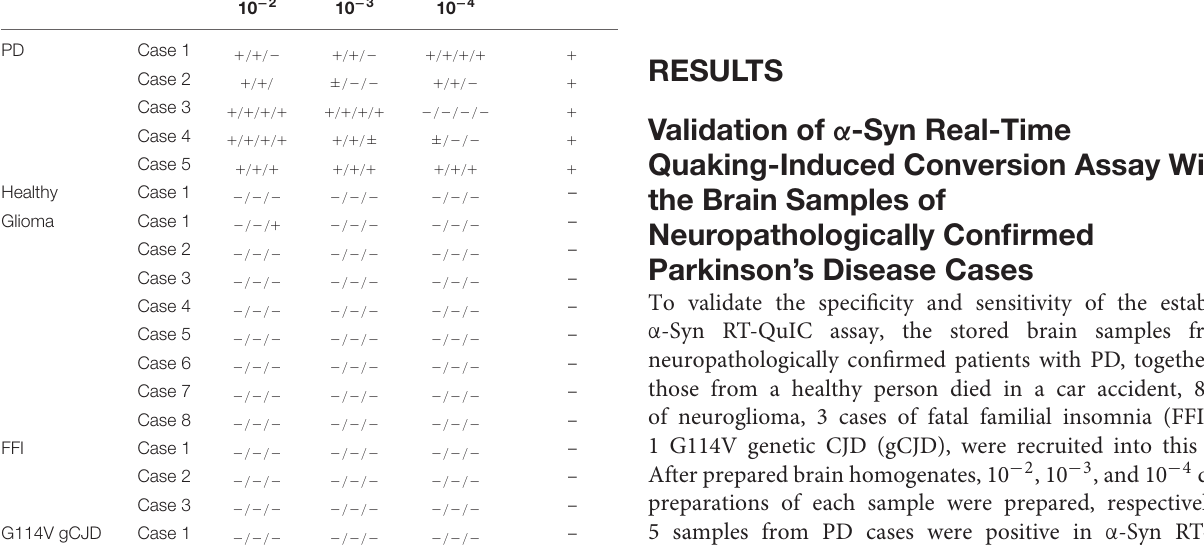
TABLE 2 | The results of the brain samples in per well at the different dilutions from patients with PD and non- α -synucleinopathies cases.